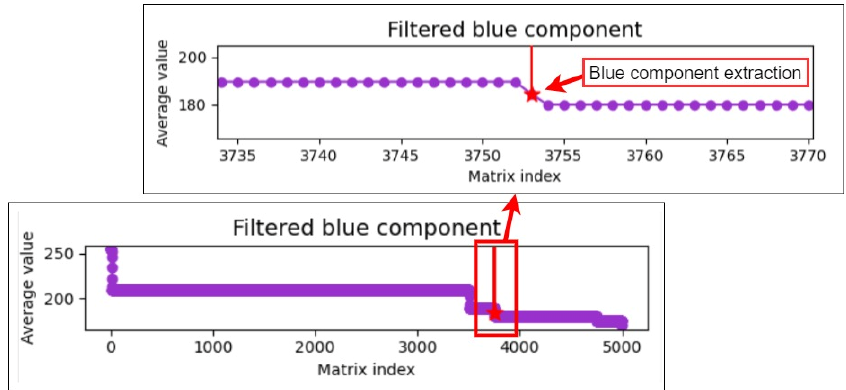
Figure 19. Upper limit extraction for the blue component.